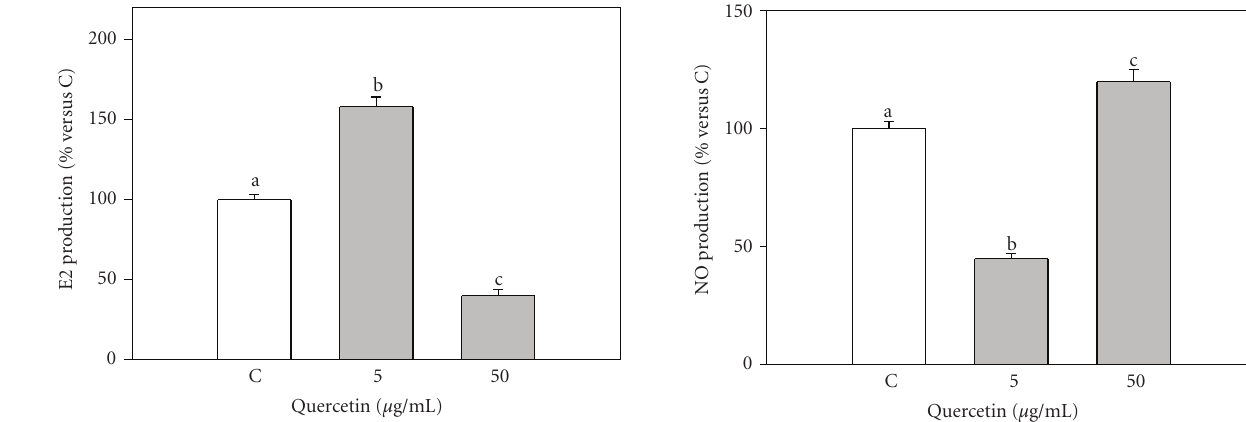
Figure 3: E ff ect of the 48-hour treatment with quercetin (5 and 50 μ g/ml) on nitric oxide production (NO) by swine granulosa cell cultured in vitro. Data represent the mean ± SEM of six replicates/treatment repeated in four di ff erent experiments. Di ff er- ent letters indicate significant di ff erences ( P < . 001) calculated by ANOVA and Sche ff `e’s F-test (Statgraphics package, STSC Inc., Rockville, Md,